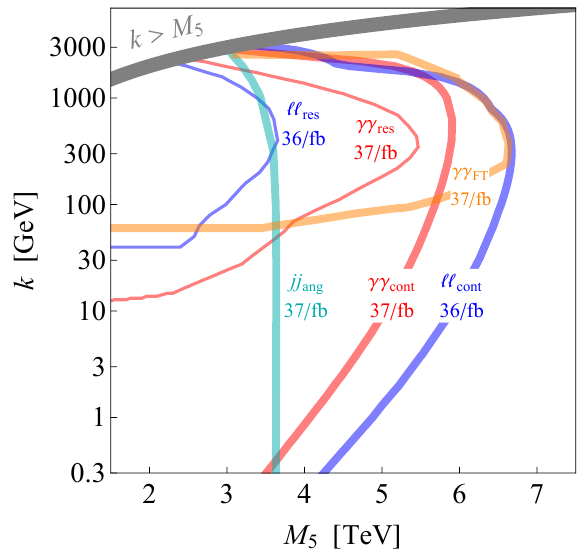
Figure 23 . Estimated sensitivity of some of the search channels, with the caveats discussed in the text. The jj ang curve refers to the search in the dijet angular distributions [74], ‘‘ res to the dilepton resonance search [63], (cid:13)(cid:13) res to the diphoton resonance searches [61, 77], ‘‘ cont to the search in the high-mass dilepton continuum [63], (cid:13)(cid:13) cont to the search in the high-mass diphoton continuum [61], and (cid:13)(cid:13) FT to our proposed Fourier transform analysis. Note that, as discussed in section 2, the region of lower k is likely to be more (cid:12)ne-tuned in a UV-completion of the